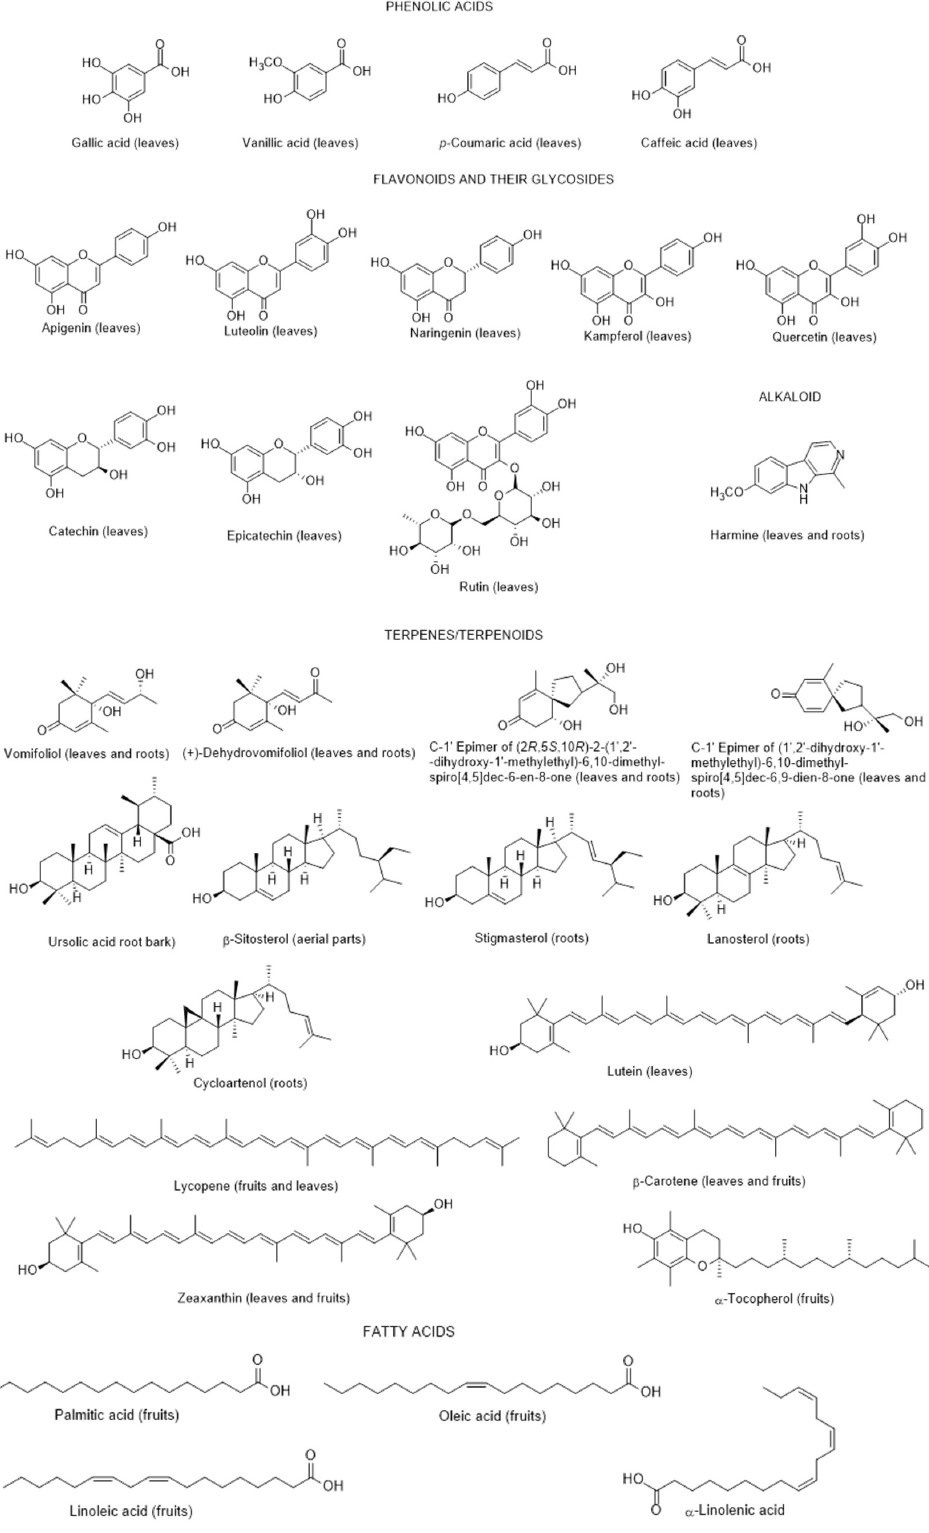
Figure 2. Metabolites found in different parts of Lycium europaeum . The antioxidant activity of ethanol extracts and their fractions (chloroform, ethyl acetate, n -butanol and aqueous) was evaluated through the capacity for scavenging some free radicals such as 1,1-diphenyl-2-picrylhydrazyl (DPPH), 2,2 ′ -azino-bis-3-ethylbenzthiazoline-6-sulphonic acid (ABTS), and superoxide anion rad- icals. Other evaluation methods were also used, such as the β -carotene bleaching assay, cupric reducing and ferric reducing activities. The capacity of the extracts and fractions for inhibiting the enzyme acetylcholinesterase, butyrylcholinesterase and urease activi- ties was also assessed. The n -butanol fraction from roots had the highest antioxidant ac- tivity in all the assays, and was also the most active against acetylcholinesterase, butyr- ylcholinesterase and urease activities (IC 50 values of 92.63, 118.26 and 135.60 μ g/mL, re- spectively). There was a correlation between the activities found and the amounts of total phenols, flavonoids, and tannins. According to the authors, roots of L. europaeum are good candidate to be explored as a source of bioactive products [72]. Methanol and ethyl acetate were the most adequate solvents for extracting the phenolic fraction of Lycium europaeum fruits that showed the highest antioxidant and an- ti-inflammatory activities. The methanol extract of L. europaeum fruits was the richest in phenolic compounds, particularly and by descending order, ferulic acid, catechin, naringenin, apigenin and gallic acid. These extracts were not effective in the inhibition of cancerous human lung carcinoma A-549, colon adenocarcinoma DLD-1 and non-cancerous human skin fibroblast WS-1 growth [73]. Although the absence of activity against these cancer cells or non-cancerous WS-1 cells, the methanolic extract had the highest capacity for scavenging the DPPH free radicals and reducing power capacity along with the water extract, nevertheless the ethyl acetate extract had better capacity for scavenging ABTS free radicals. The ex vivo studies, using the dichlorofluoresce- in-diacetate in a cellular-based assay showed that ethyl acetate and methanol extracts were the most promising samples. According to the authors [73] only the DPPH assay did not correlate with the phenol or flavonoid concentrations of the extracts. In this case, the authors [73] suggested that polysaccharides, alkaloids and terpenoids have an im- portant role on the antioxidant activity along with the phenols. The same authors con- clude that such results may indicate the possible utilization of L. europaeum fruits as a source of bioactive molecules or products for pharmaceutical industry. 2.1.2. Fungal Infection Arthrocladiella mougeotii (Ascomycota, Helotiales) is the only fungus species that in- fects various species of Lycium worldwide in places such as Russia, Europe, China, Japan, New Zealand, USA, Turkey and Israel. For the first time, the infection of L. europaeum by Arthrocladiella mougeotii was reported in Iran. In the same work, the authors revealed that this infection was previously reported in other plant species ( Deutzia gracilis ), albeit after reexamination of the plant material and compared with type material of D. gracilis and two authentic herbarium specimens of L. europaeum , in the JSTOR Global Plants database, the authors concluded that there had been a misidentification. With this finding, the au- thors reported an infection of L. europaeum by Arthrocladiella mougeotii for the first time, in Iran [74]. 2.2. Lycium schweinfurthii Dammer